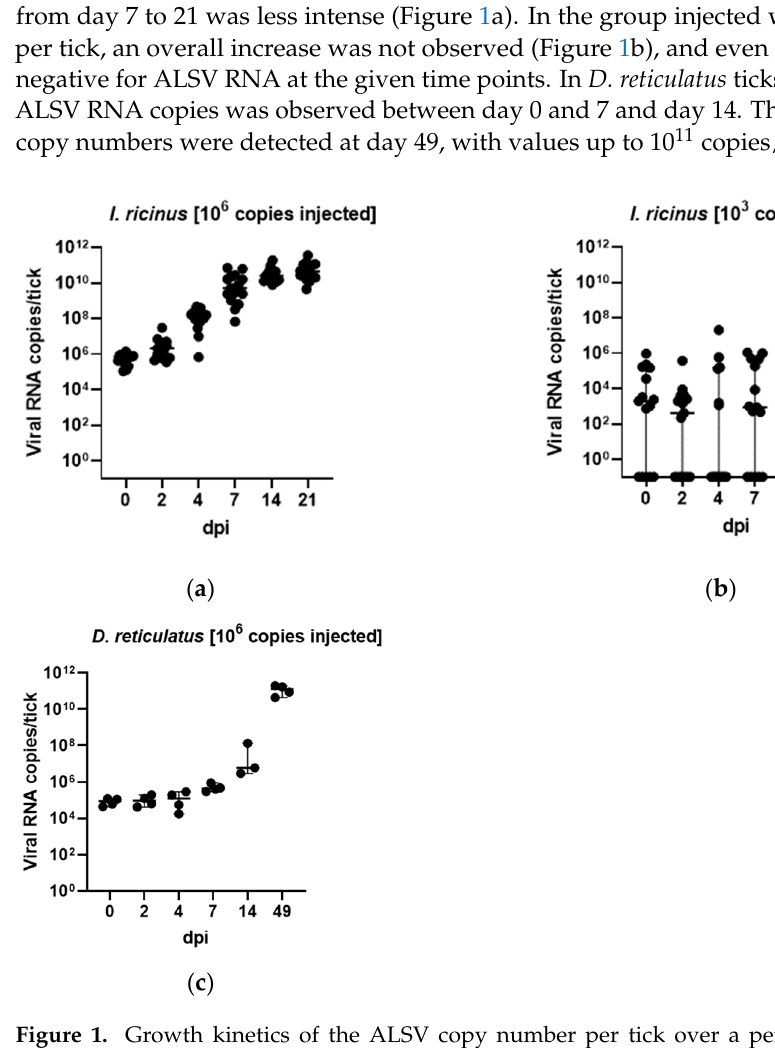
Figure 1. Growth kinetics of the ALSV copy number per tick over a period of 21 or 49 days. ( a ): Growth kinetics of I. ricinus with 10 6 copies inoculum; ( b ): Growth kinetics of I. ricinus with 10 3 copies inoculum. The experiment was repeated three times for I. ricinus . ( c ): Growth kinetics of the ALSV copy numbers per D. reticulatus tick over a period of 49 days and inoculum of 10 6 copies/tick. The experiment was conducted